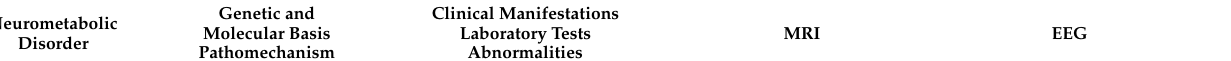
Table 1. This table shows characteristic features of various neurometabolic